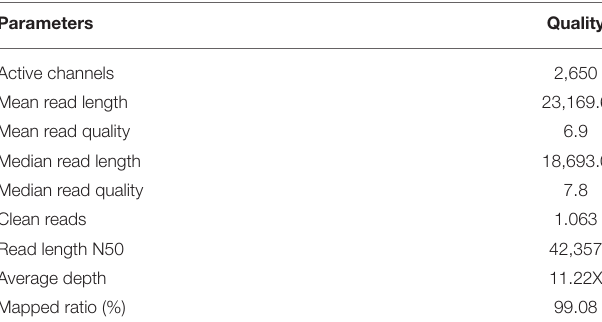
TABLE 3 | Summary of sequence data from the nanopore sequencing.